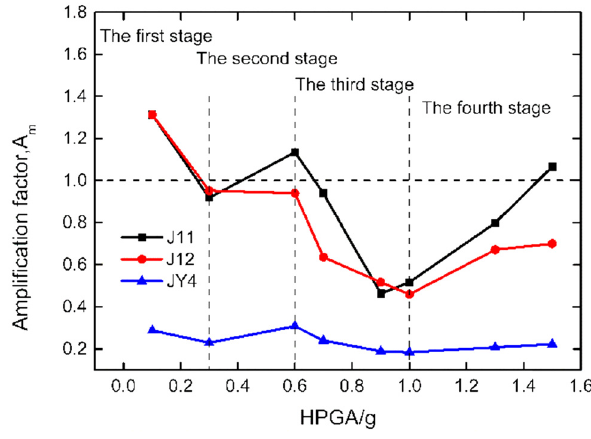
Figure 10: Ampli fi cation factor A m at J11, J12, and JY4 against di ff erent